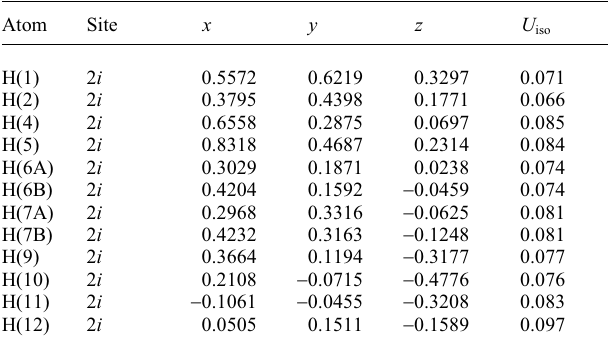
Table 2. Atomic coordinates and displacement parameters (in Å 2 )